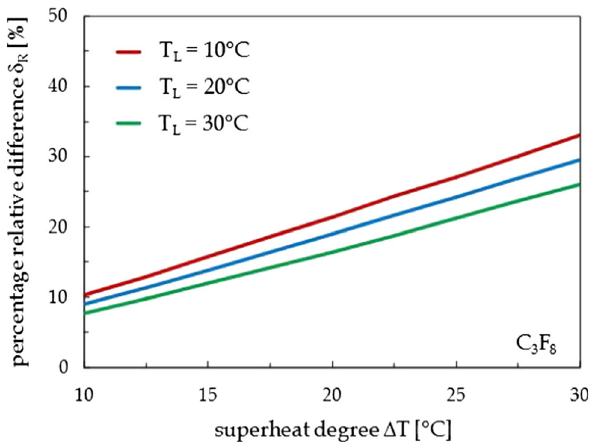
Fig. 6 Distributions of δ R = ( R c − R ∗ c )/ R c vs. (cid:4) T for C 3 F 8 using T L as a parameter